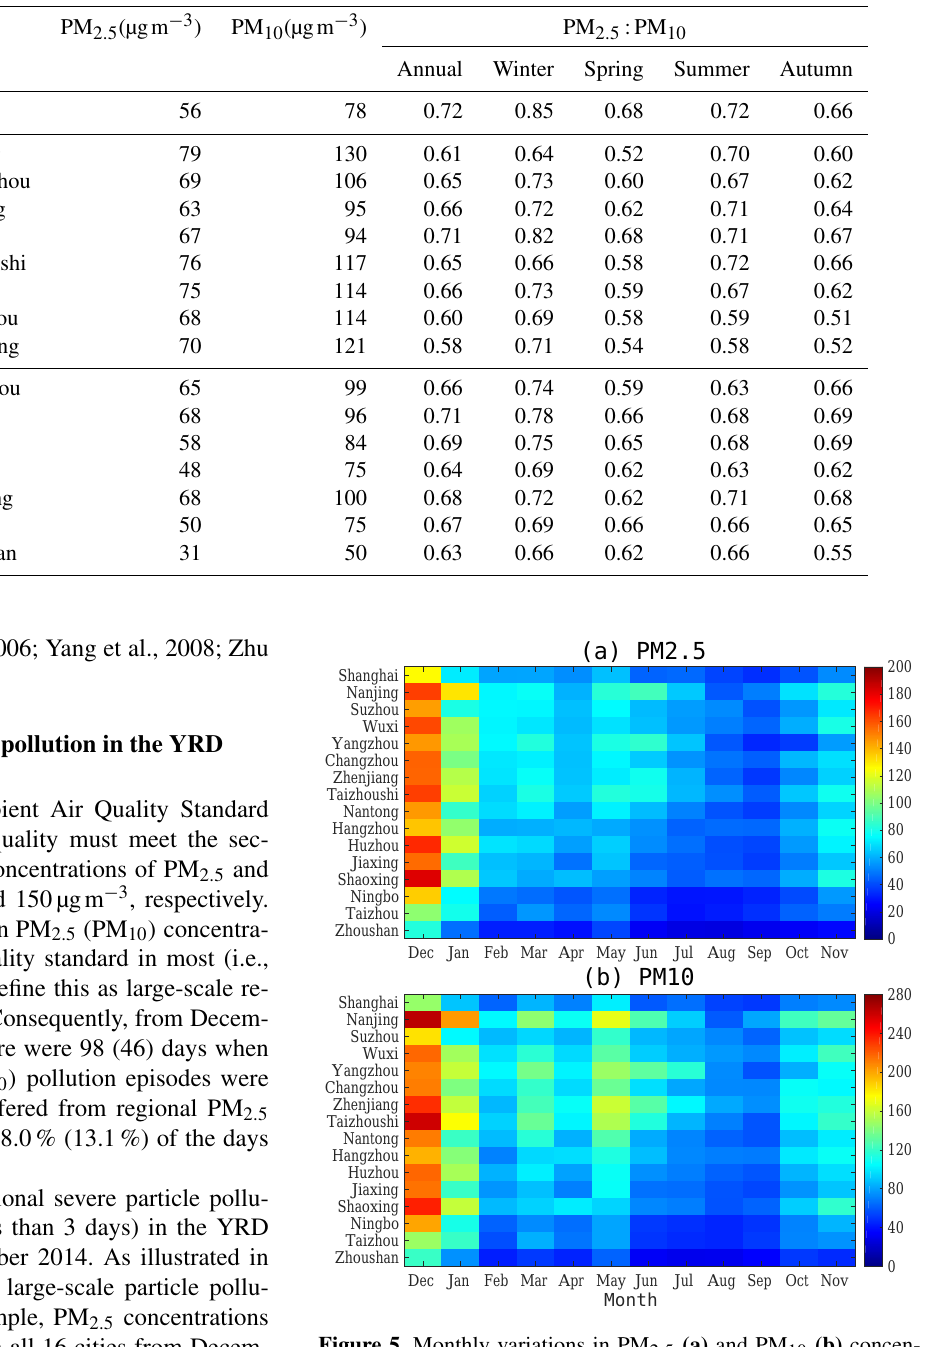
Table 1. Annual mean concentrations of PM 2 . 5 and PM 10 and the annual and seasonal mean values of PM 2 . 5 : PM 10 ratios in 16 cities of the YRD.